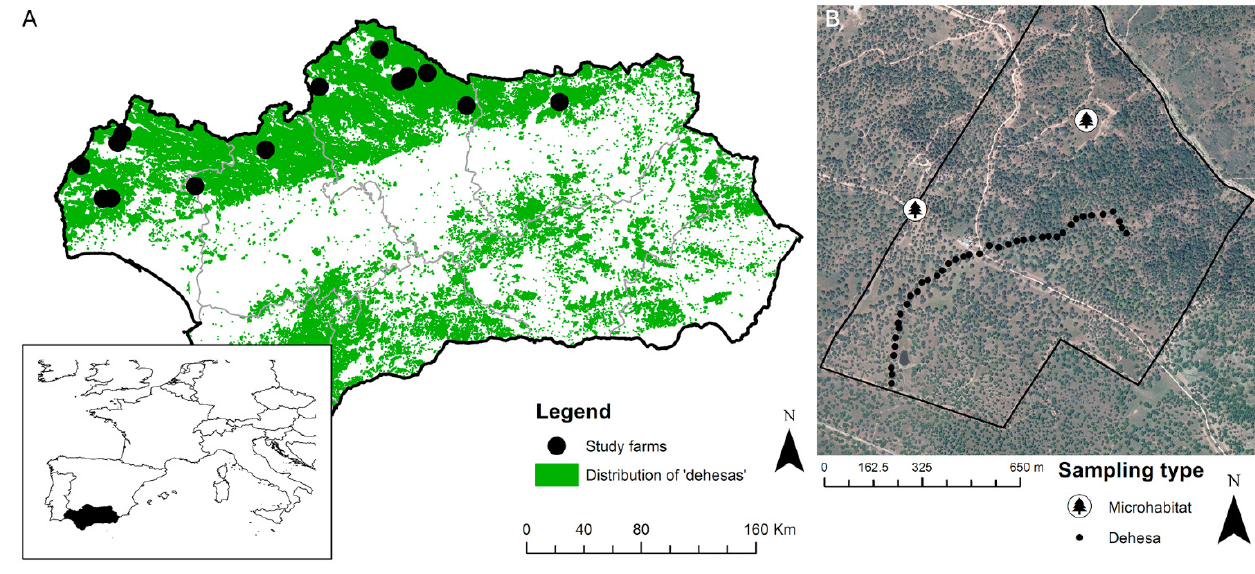
Fig 1 . A) Location map of the study ‘dehesas’ (layer of distribution of ‘dehesas’ from REDIAM: Andalusian Environmental Information Network). B) Pitfall traps position according to both sampling types (‘dehesas’ and microhabitats) for the farm AS05, as an